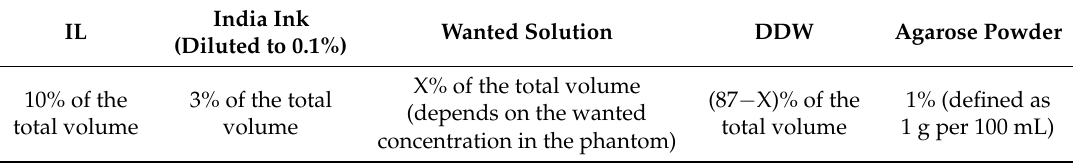
Table 4. Specification of the volume’s ratios of the materials needed for a phantom preparation. India Ink IL Wanted Solution DDW Agarose Powder (Diluted to 0.1%) X% of the total volume 10% of the 3% of the total (depends on the total volume volume